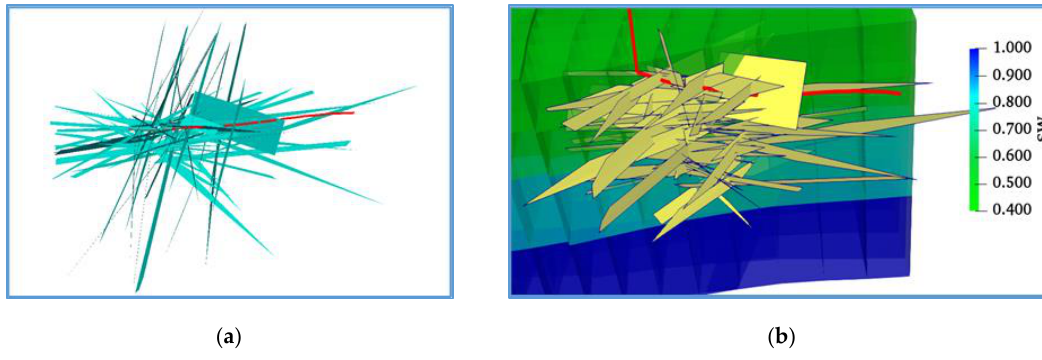
Figure 26. Six shortest fracture paths from well B2 to the water contact: ( a ) 3D visualization of the fractures paths along the wellbore; ( b ) shortest fractures planes embedding the grid blocks which display a vertical intersection plane view of the water saturation of the